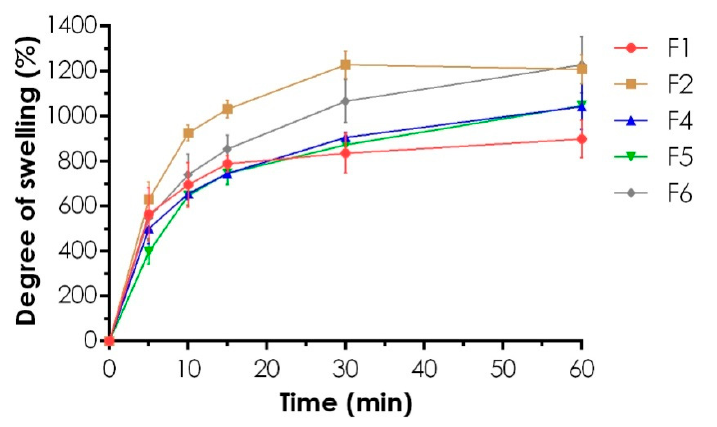
Figure 5. The swelling profiles of the hydrogels in SS expressed as the degree of swelling (mean ± SD, n = 3).